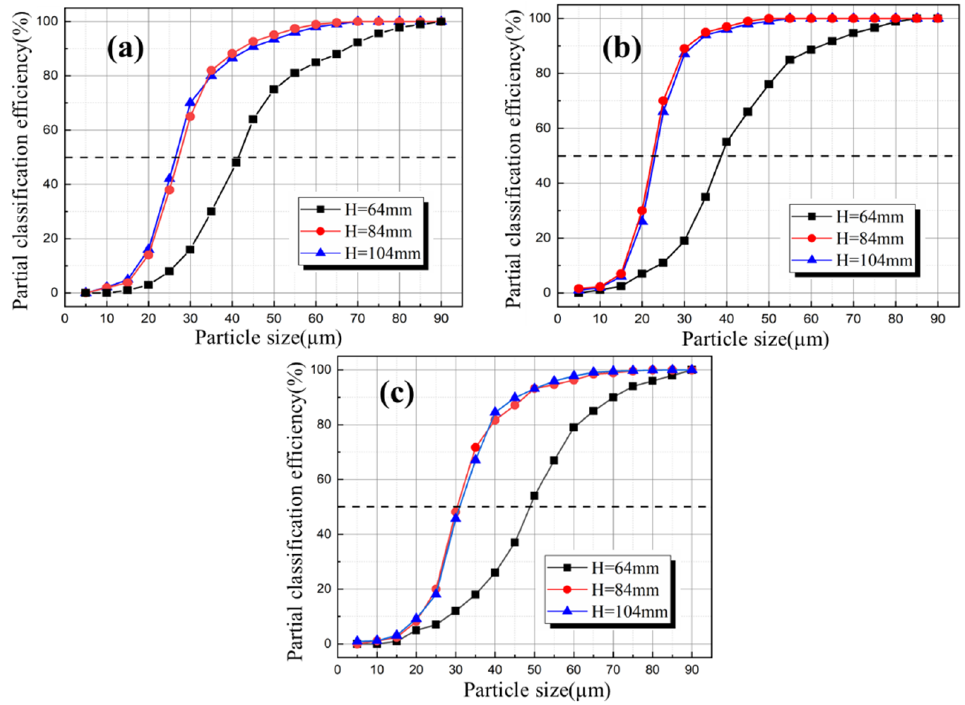
Figure 10. Tromp curves of classifiers with different guide cone heights: ( a ) 14 m/s ‐ 500 rpm, ( b ) 14 m/s ‐ 600 rpm, ( c ) 16 m/s ‐ 500 rpm.